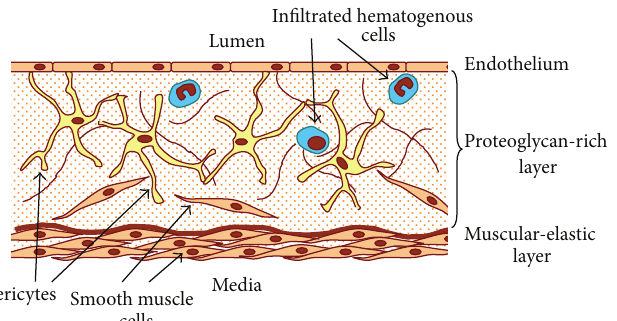
Figure 1: Schematic representation of the proteoglycan-rich layer of human aortic intima. Stellate macrovascular pericytes form a three- dimensional cellular network in the subendothelial layer of intima forming contacts with each other and other cell